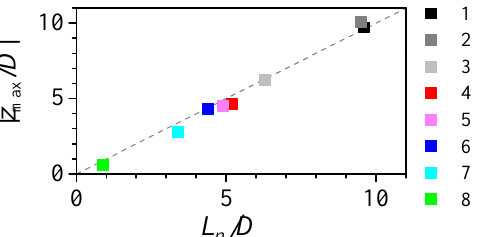
Figure 6. Maximum strain rate position z max versus the neck length L n for Q = 5 µ L/min. The colour indicates the nozzle number in Table 1. The dashed line has slope